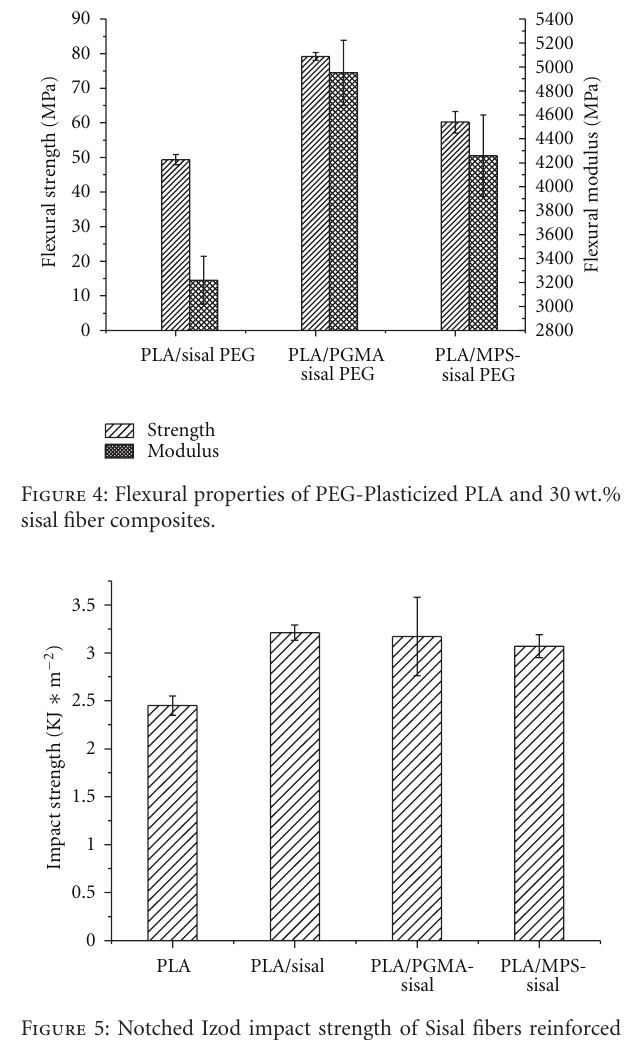
Figure 5: Notched Izod impact strength of Sisal fibers reinforced PLA composites.